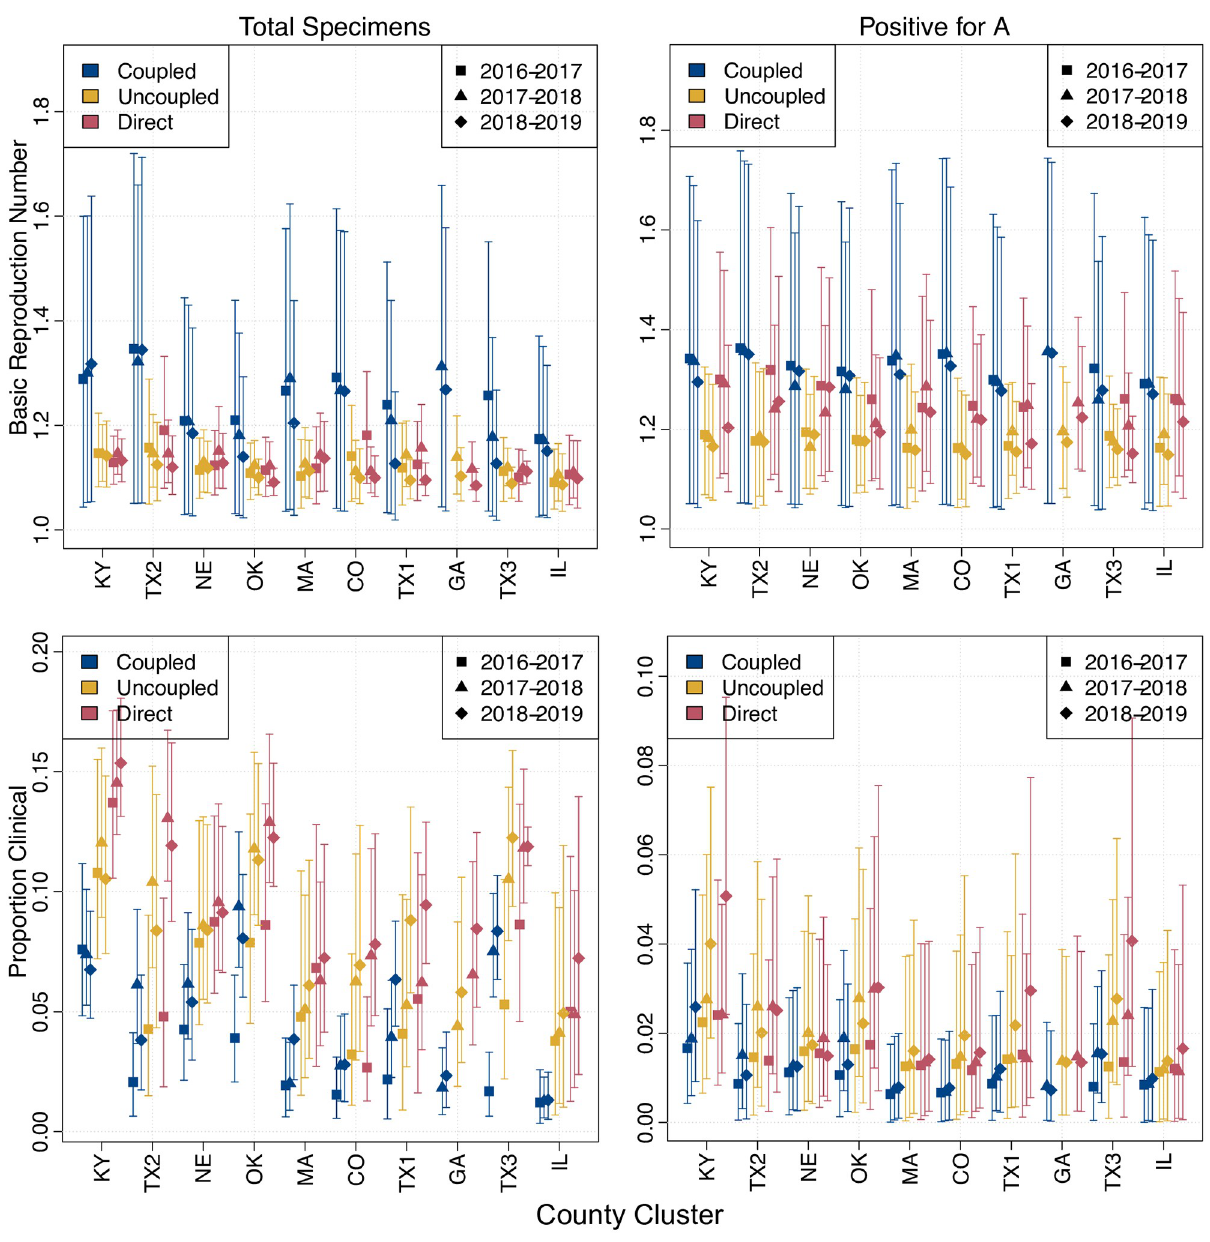
Fig 5. Posterior parameter densities by season, cluster and model type. Bars show central 95% of posterior credibility interval with marker showing posterior mean. Colour indicates model type and symbol shape indicates season. Values for each cluster are grouped together as per x-axis tick labels.